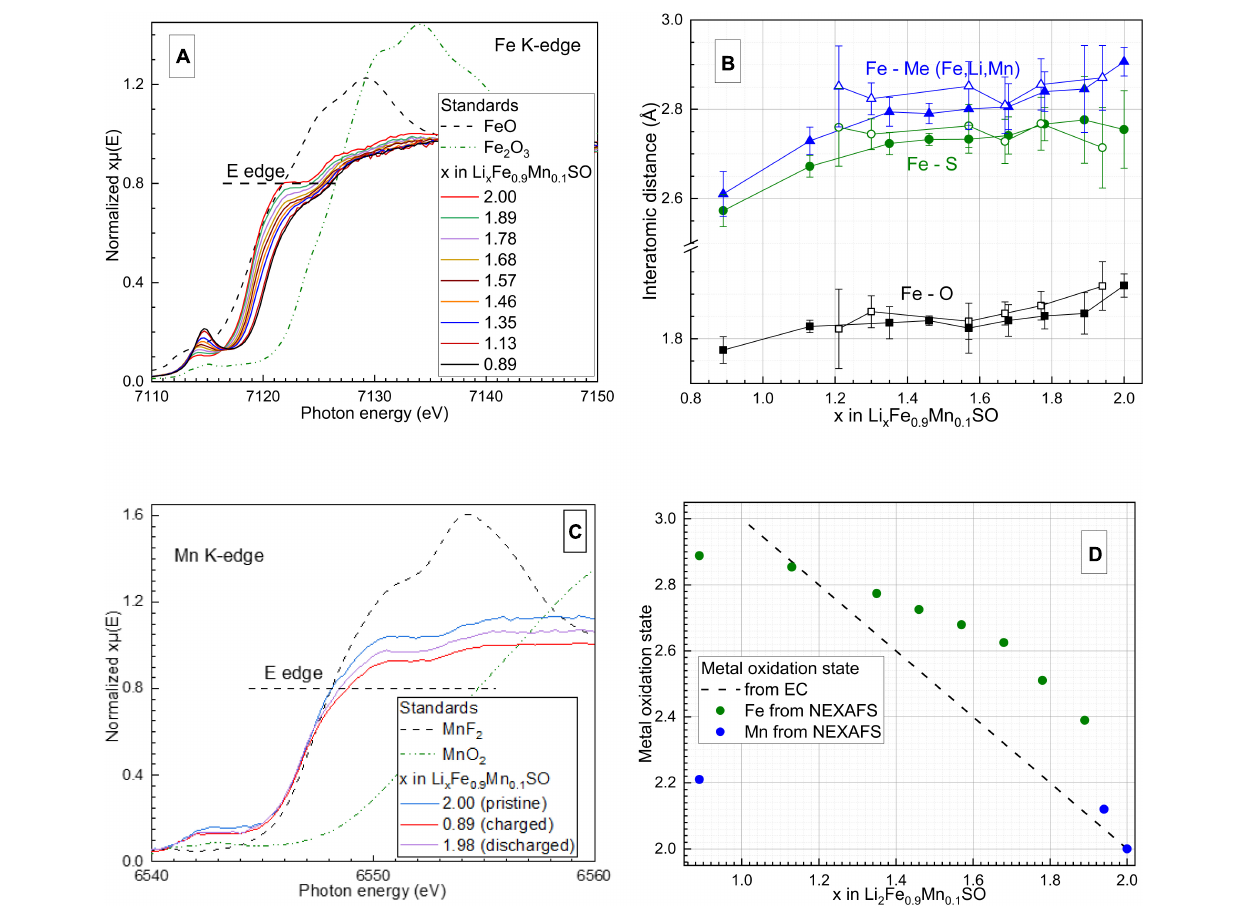
FIGURE 7 | (A) Normalized Fe K-edge X-ray absorption spectra of Li 2 Fe 0 . 9 Mn 0 . 1 SO recorded operando . (B) Average interatomic distances for iron estimated by extended X-ray absorption fine structure calculations with their confidence intervals. Filled points correspond to the charging, unfilled–to the discharging process. The scale of the Y-axis is the same before and after the break). (C) Normalized Mn K-edge X-ray absorption spectra of the same material recorded operando. (D) Average oxidation states of metals in Li 2 Fe 0 . 9 Mn 0 . 1 SO estimated from the electrochemical measurements and XAS studies. The position of the Fe K-edge was defined as the energy at the X-ray absorption coefficient µ (E) = 0.8 of normalized post-edge intensities as well. TABLE 1 | Interatomic distances in pristine Li 2 Fe 0 . 9 Co 0 . 1 SO and Li 2 Fe 0 . 9 Mn 0 . 1 SO materials calculated from synchrotron XRD and EXAFS data analysis. Compound XRD EXAFS Atoms Interatomic distance (Å) Atoms Interatomic distance (Å) Li 2 Fe 0 . 9 Co 0 . 1